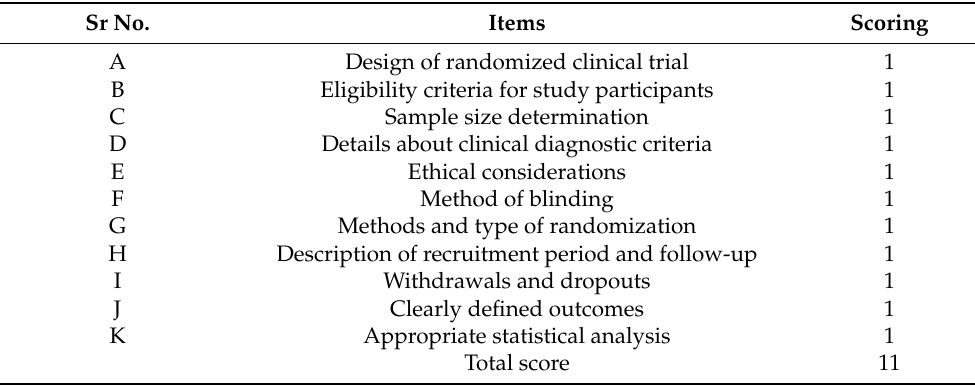
Table 1. Methodological quality